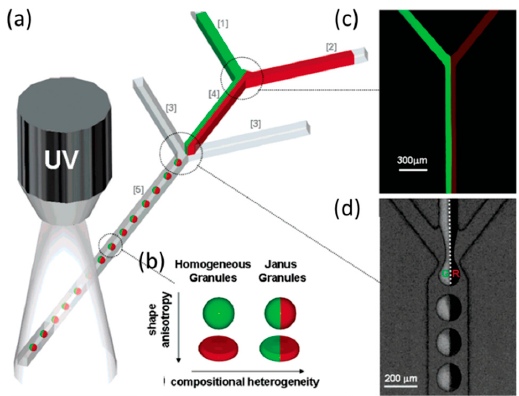
Figure 11. ( a ) Schematic representation of sheath-flow microfluidic device used to produce monodisperse colloid-filled hydrogel granules; ( b ) Schematic view of granule shapes and compositions explored; ( c ) Fluorescent image of Y-junction formed by inlets [1,2] for the production of Janus spheres; ( d ) Backlit fluorescence image (green excitation) illustration that the fluorescein isothiocyanate (FITC)-silica microspheres remain sequestered in the left hemisphere of each granule generated. Pictures are from [124]. Reproduced with permission from Shepherd, R.F., et al., Langmuir ; published by American Chemical Society, 2006.